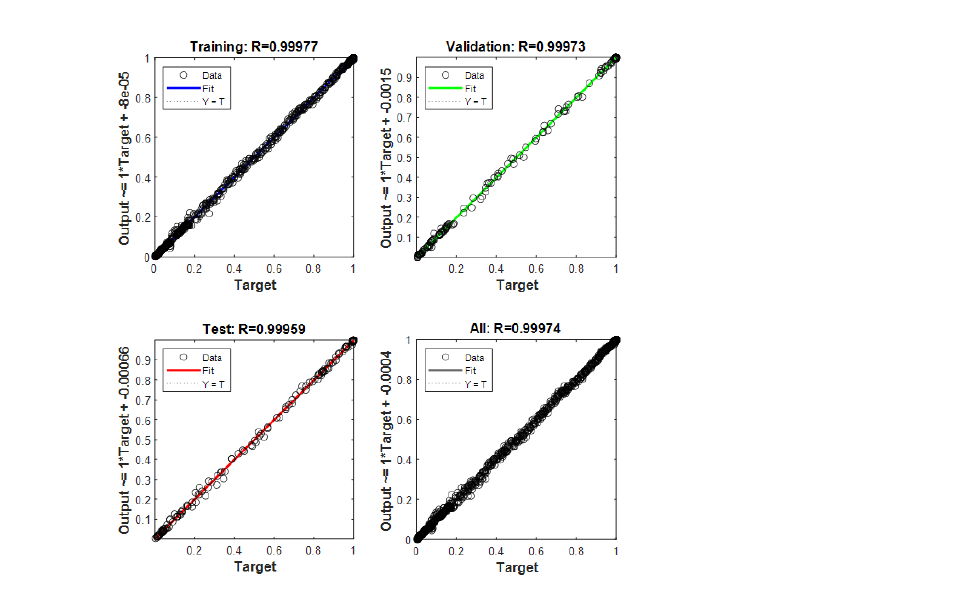
Figure 9. Variation of MSE value with respect to epochs at optimal neural network.